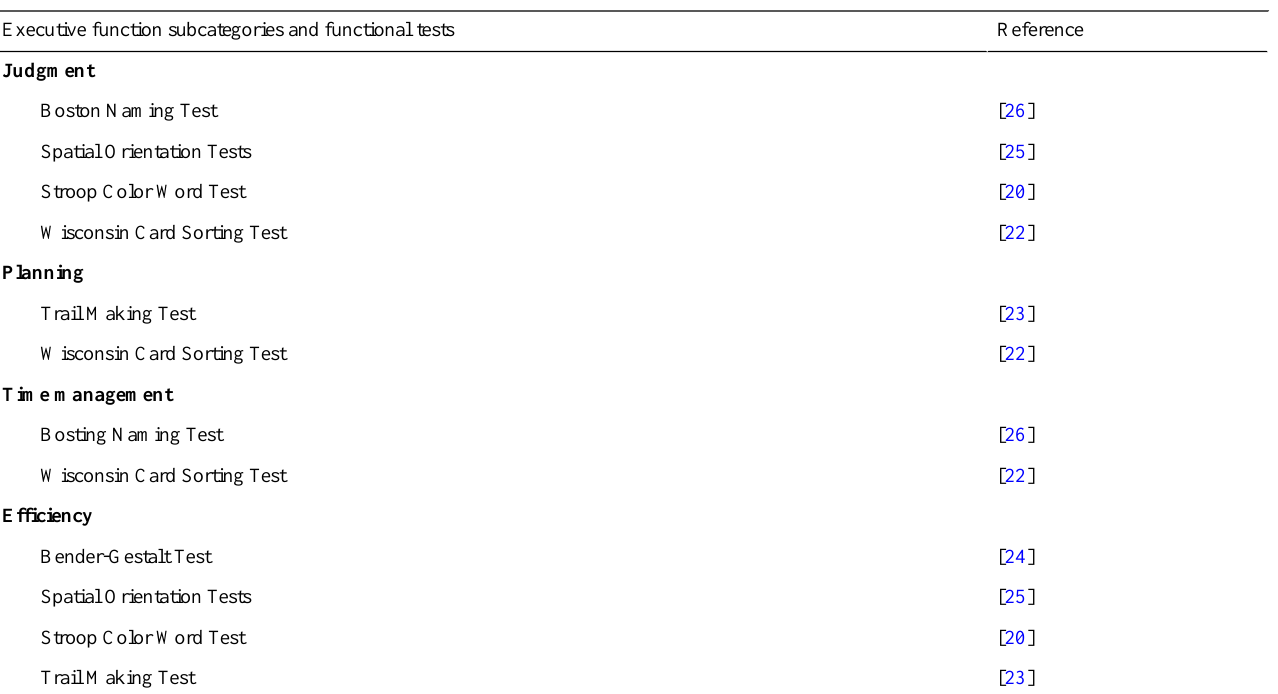
Table 8. Executive function tests and assessment